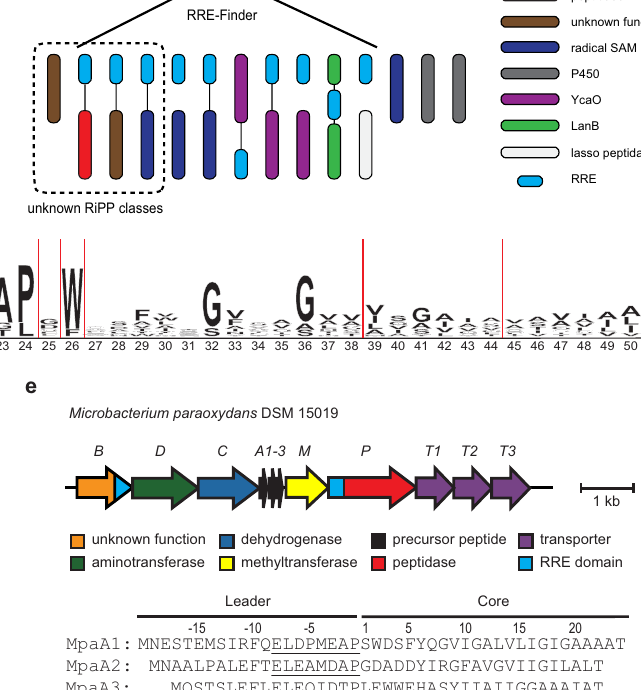
strainB4082 (Supplementary Fig.4, SupplementaryData 1). PSI-BLAST